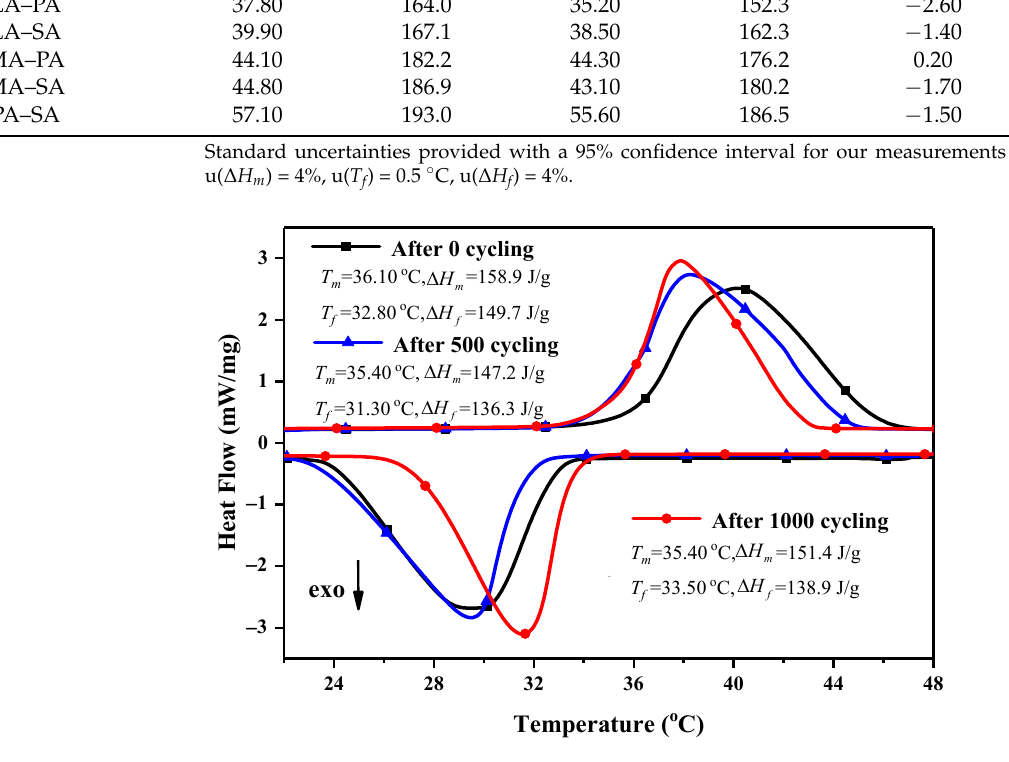
Figure 6. LA–MA PCMs DSC curves before and after thermal cycling. The samples of LA–MA PCMs eutectic mixtures were measured by FTIR to judge whether the composition of the mixture has changed before and after thermal cycling, and the infrared spectrum is shown in Figure 7. Compare the spectra in Figure 7a,b, it is found that the peaks of the two spectra are in the same frequency band and match each other, and the characteristic peaks have not changed, indicating that there is no change in the composition of LA–MA PCMs eutectic mixtures before and after thermal cycling. As a result, after thermal cycling, the mixtures do not experience any chemical deterio ‐ ration.